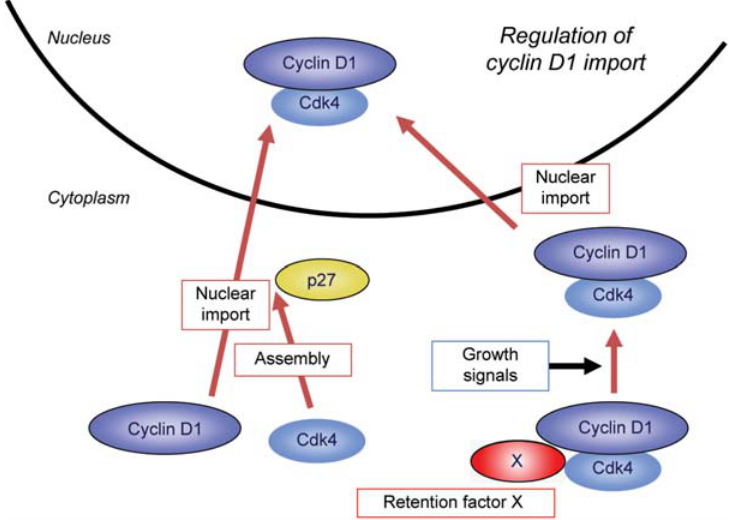
Figure 3 Regulation of the nuclear import of cyclin